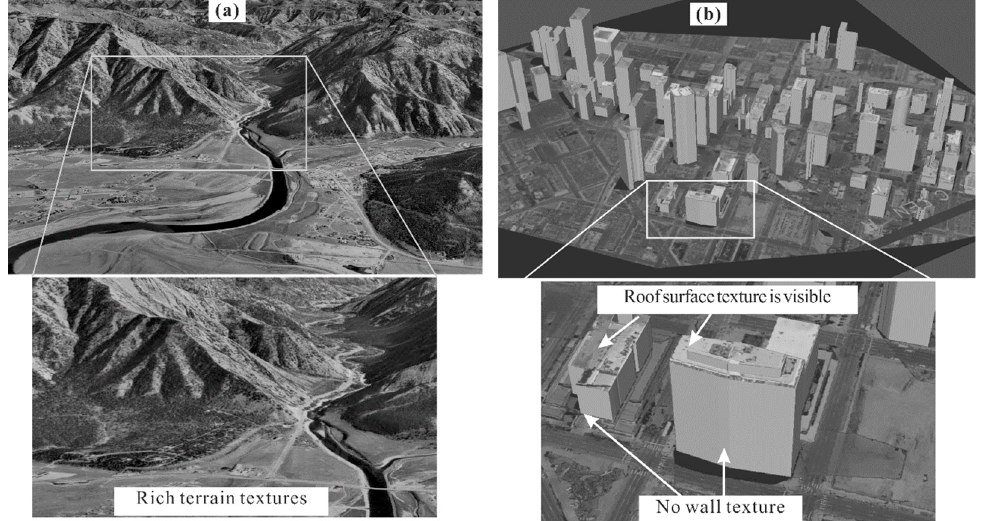
Figure 1. ( a ) Terrestrial textures visible in flat and hilly area when TOM is superimposed on DTM (http://www.pcvr.com.cn/html/software/softwarei.html (accessed on 5 August 2022)), and ( b ) building façade texture visible when DOM is superimposed on DBM.